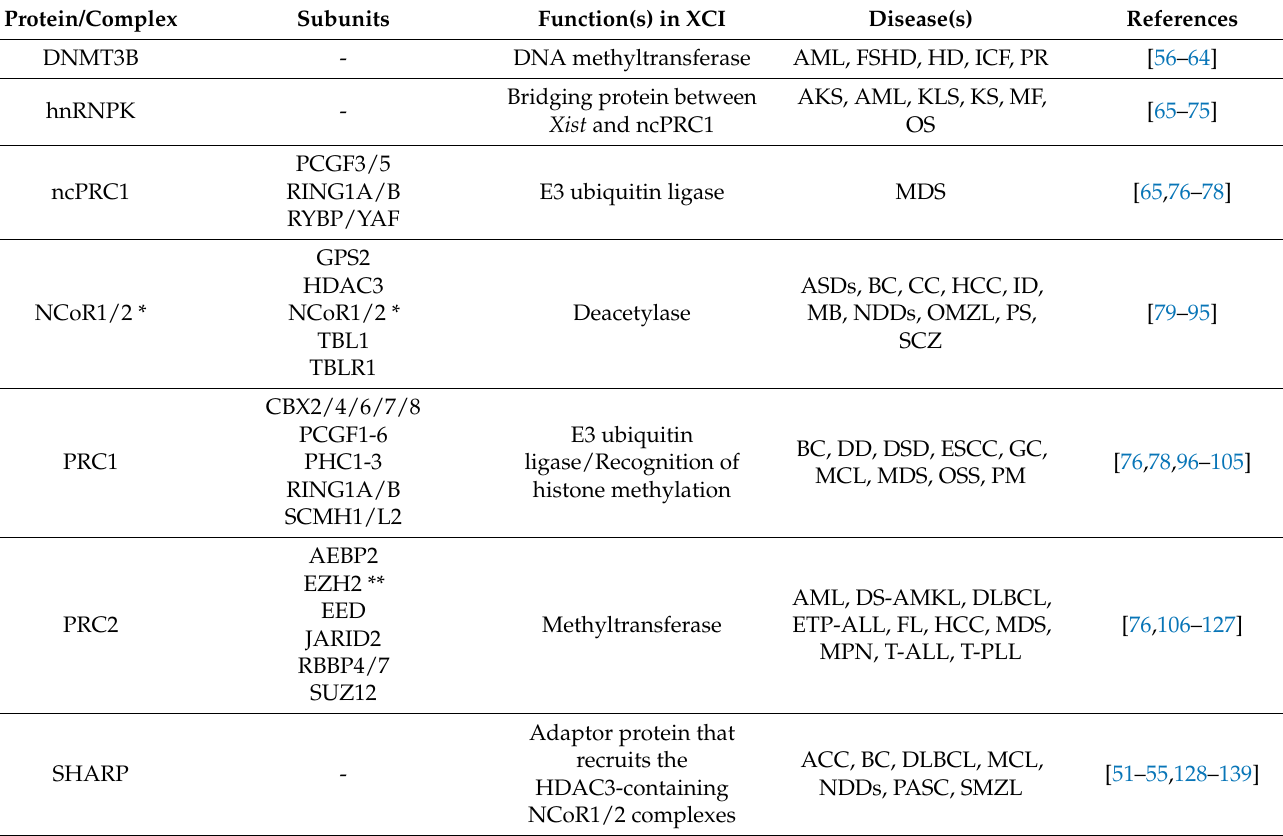
Table 1. Proteins and complexes involved in the regulation of X chromosome inactivation (XCI). The “Disease(s)” column indicates diseases caused by mutations in the XCI related genes/proteins described in this table. The functional link between these mutations and XCI remains to be